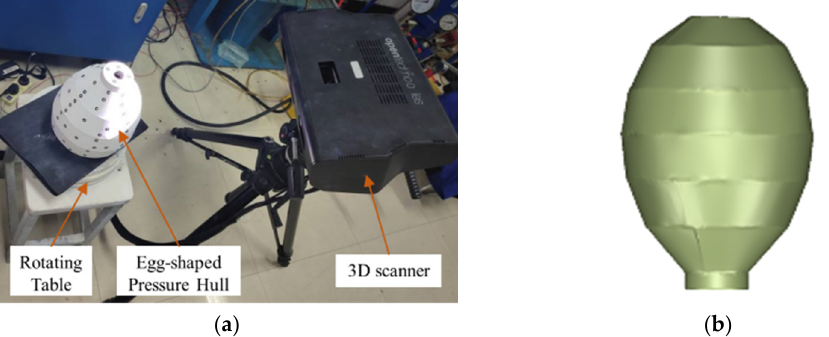
Figure 17. Scanning scene photo of the hull ‘a’ and generate the actual digital model: ( a ) Scanning scene; ( b ) Actual digital model.